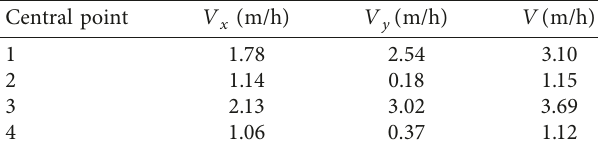
Table 3: Water velocity at the center point.